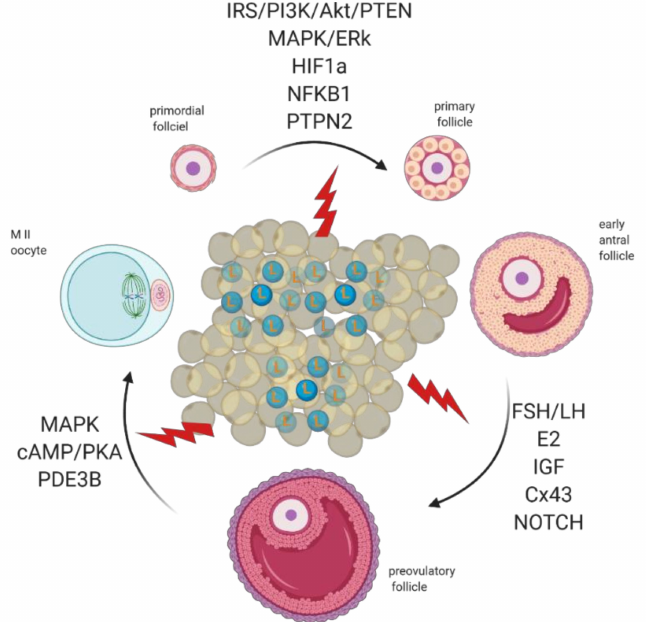
Figure 6. Adipose tissue secretes excessive amounts of leptin (L) during obesity. Leptin signaling